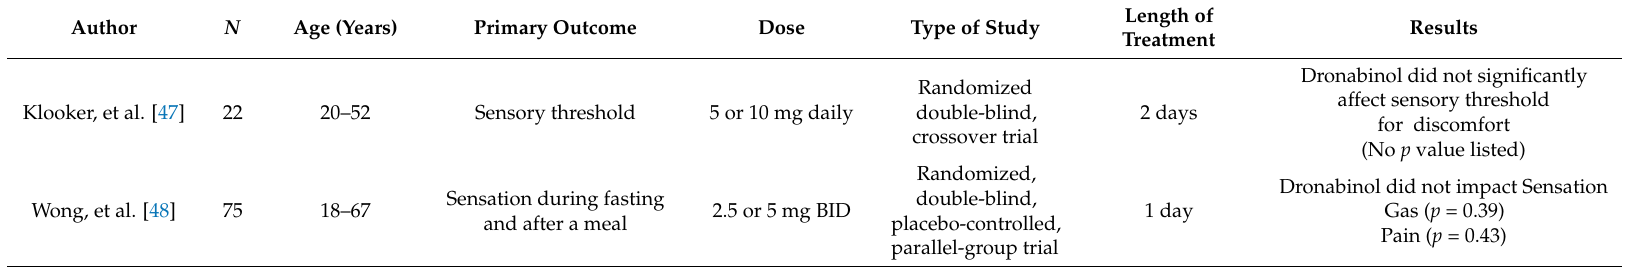
Table 4. Clinical Trials on Cannabis in the treatment of functional gastrointestinal